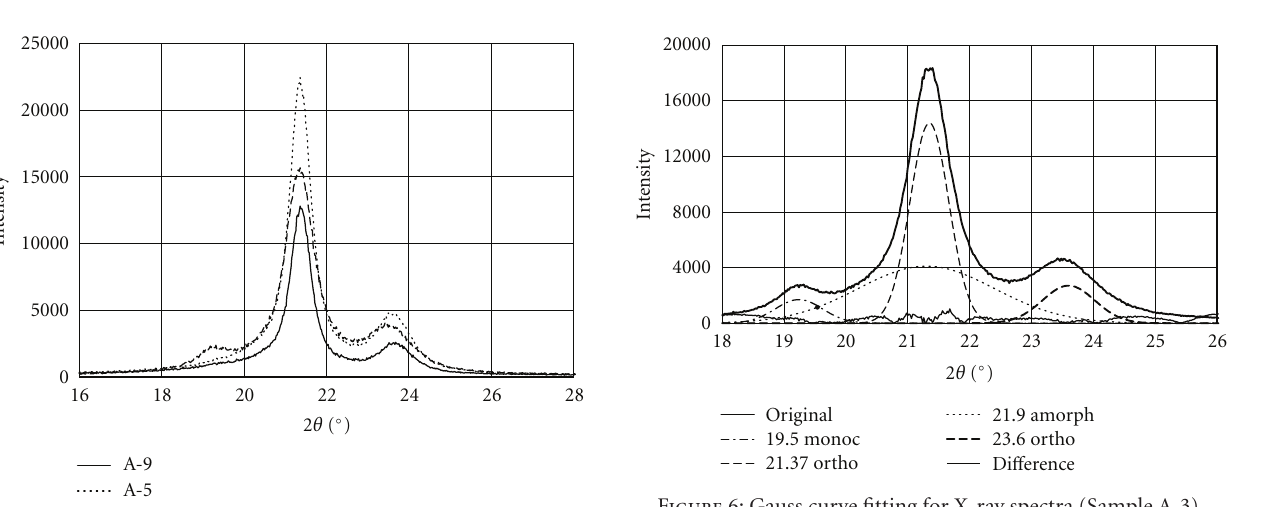
Figure 6: Gauss curve fitting for X-ray spectra (Sample